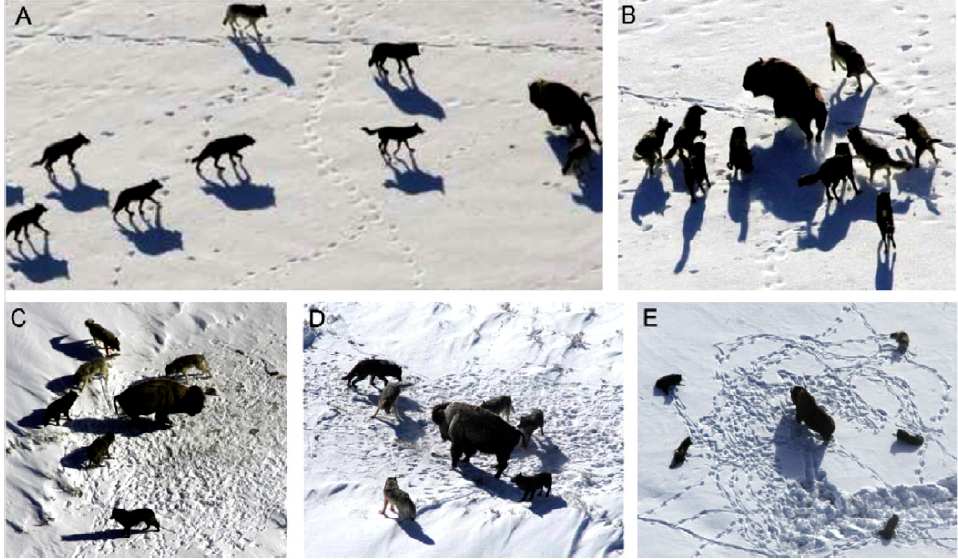
Figure 3. Hunting behavior of gray wolves: ( A ) chasing, approaching, and tracking prey ( B – D ) pur- suing, harassing, and encircling ( E ) stationary situation and attack